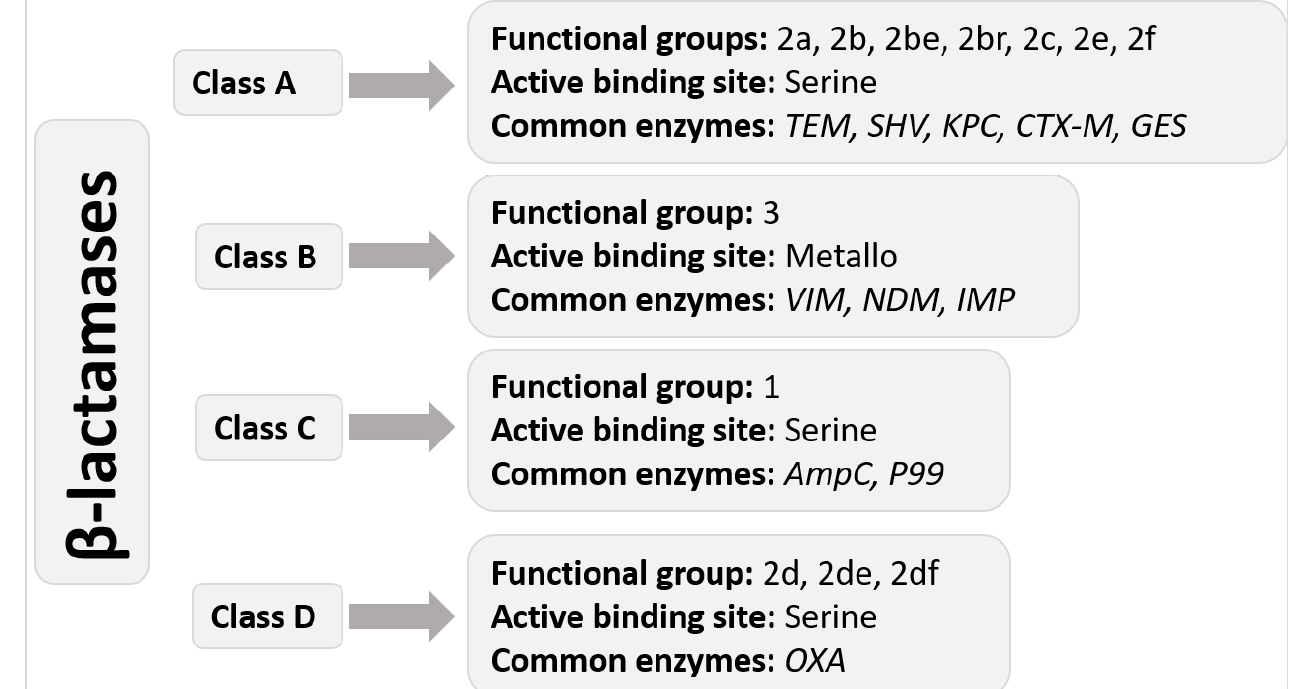
Figure 1. Ambler molecular classification of beta-lactamases.